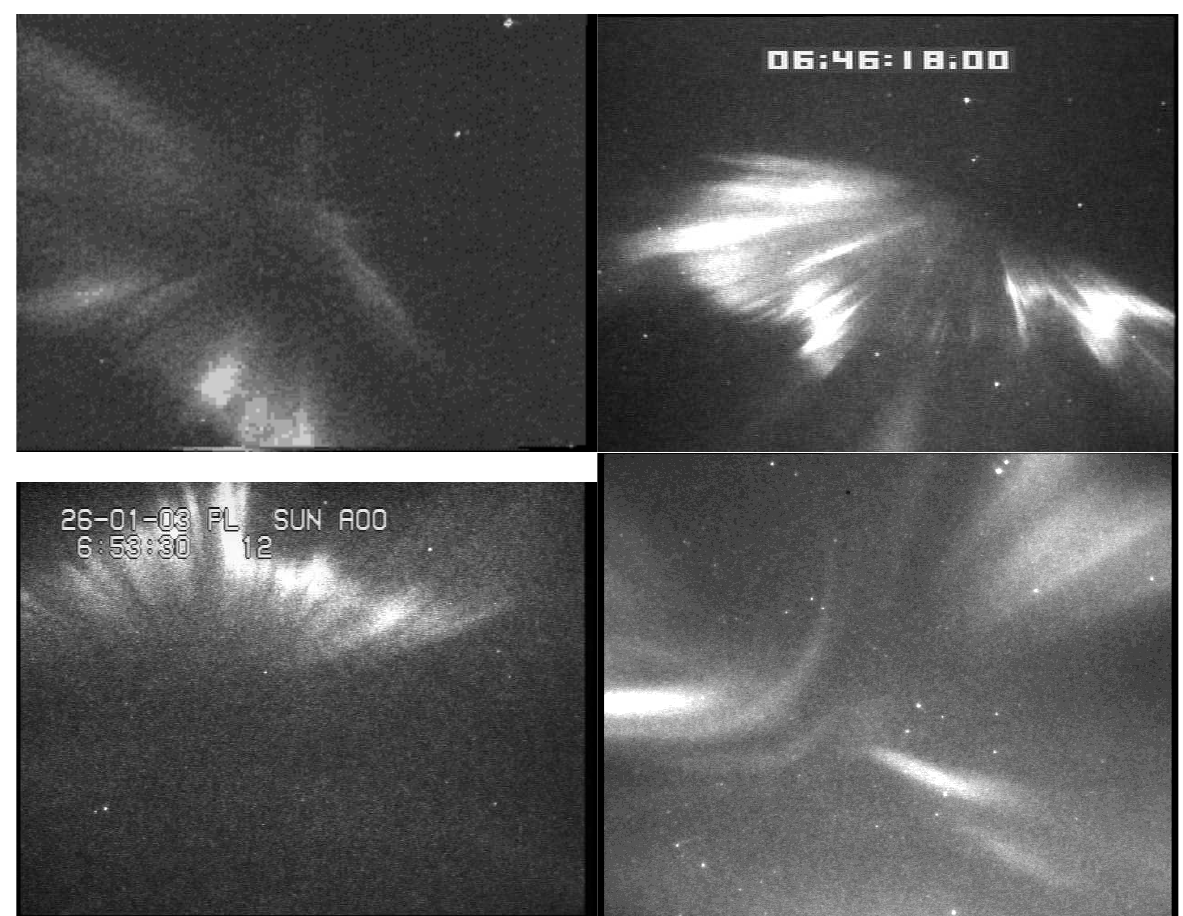
Fig. 1. Typical images from three of the events, and a fourth image, in the lower right frame, which shows a coronal aurora from event X with no associated enhanced ion-acoustic echoes. The upper left frame is from event 1, the upper right from event 3, and the lower left frame from event